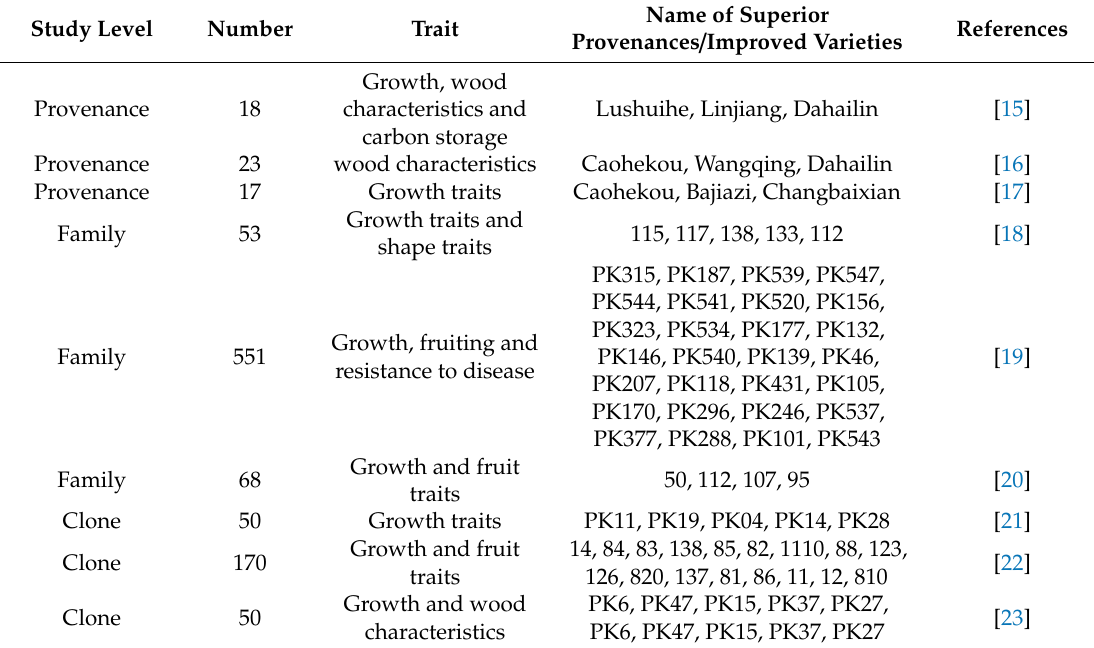
Table 1. Studies made on genetic improvement of Pinus koraiensis